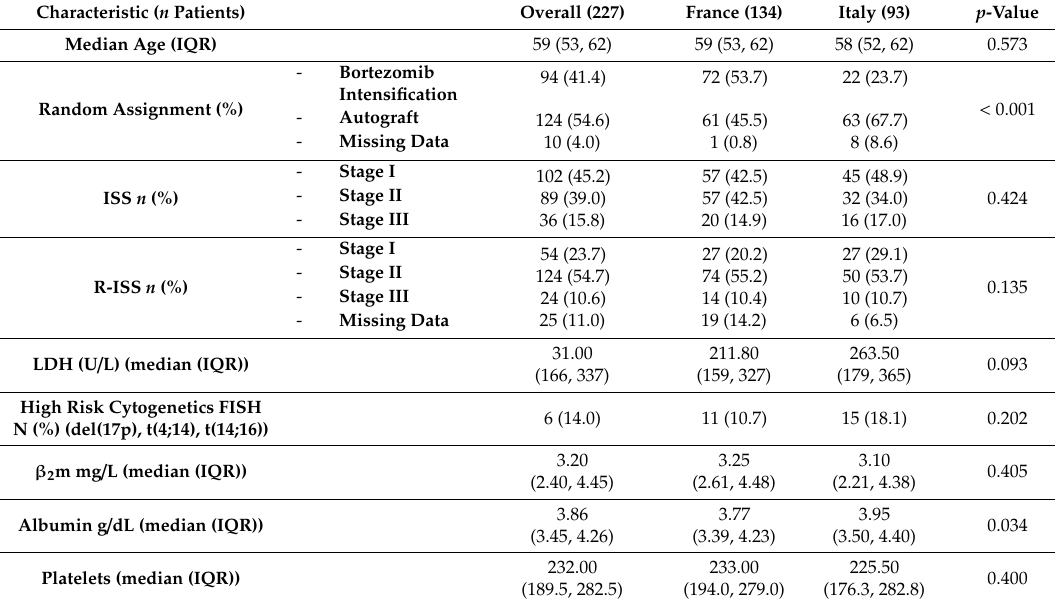
Table 1. Patient characteristics at baseline.